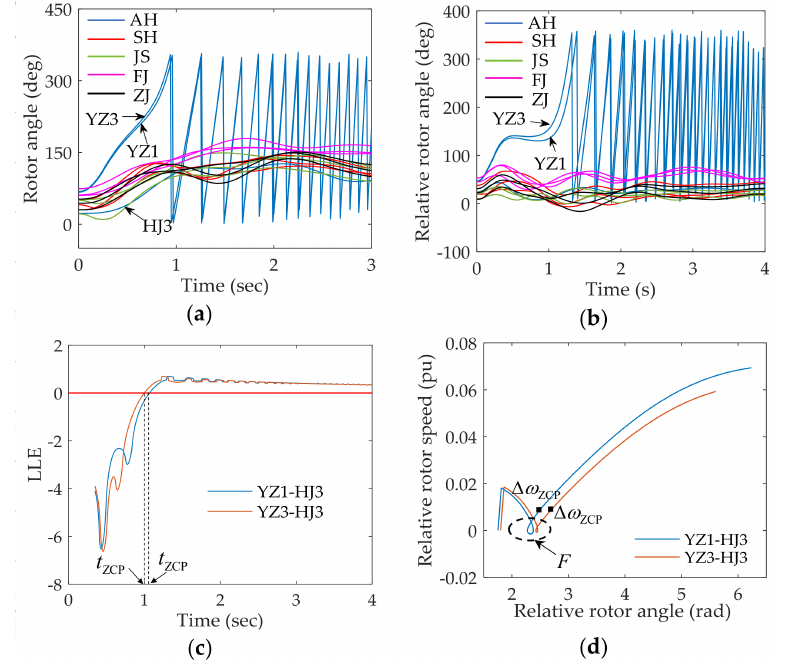
Figure 11. Simulation results for Case 4: ( a ) Rotor angle curves of generators after fault; ( b ) relative rotor angle curves after fault (HJ3 is the reference generator); ( c ) LLE–time curves; ( d ) phase-plane trajectories after clearing the